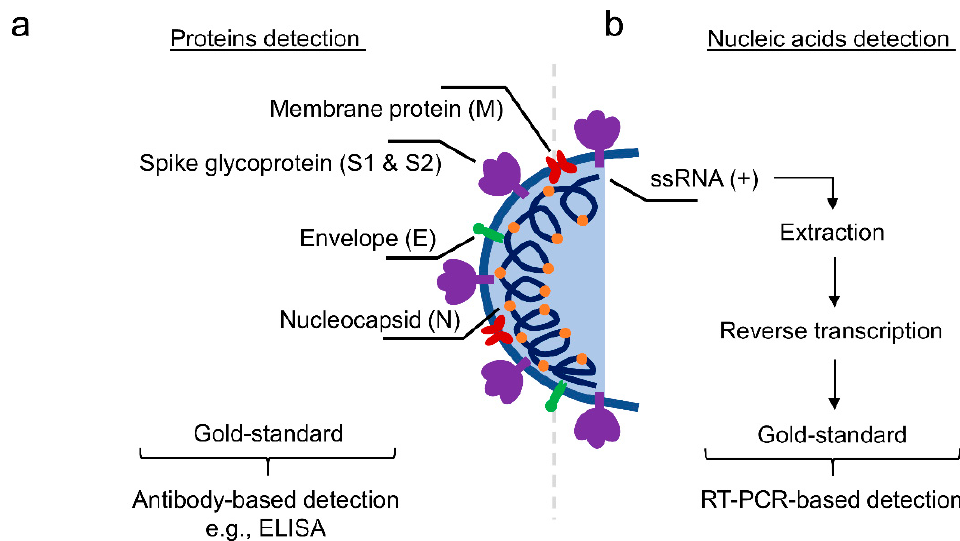
Figure 1. Schematic illustration of structural components of SARS-CoV-2. ( a ) Protein-based biomarkers for viral detection. ( b ) Nucleic acids-based biomarkers for viral detection.